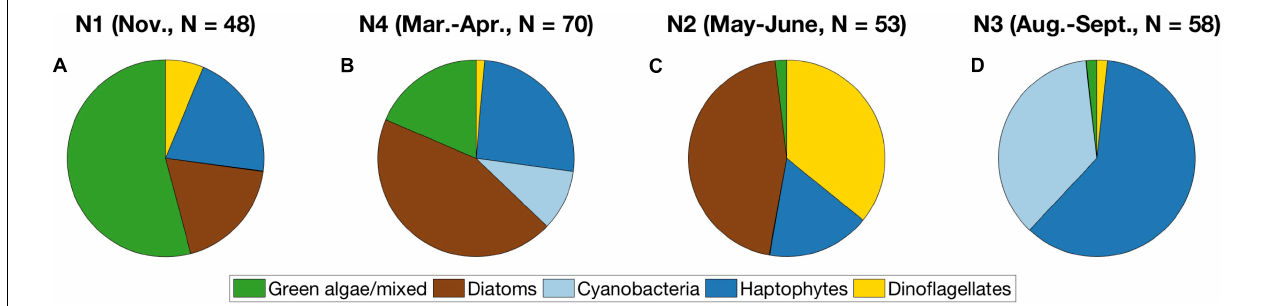
FIGURE 8 | Proportion of samples in each community detected using network-based community detection and EOF regression on NAAMES 1-4, arranged in seasonal order: (A) winter, (B) early spring, (C) early summer, (D) early fall. Colors correspond to the dominant community (light blue = cyanobacteria, dark blue = haptophytes, green = green algae, brown = diatoms, gold = dinoflagellates).